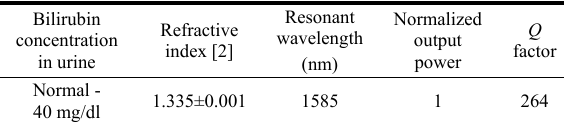
Table 7 Bilirubin concentration in urine and its refractive index, resonant wavelength, normalized output power, and Q factor of the proposed